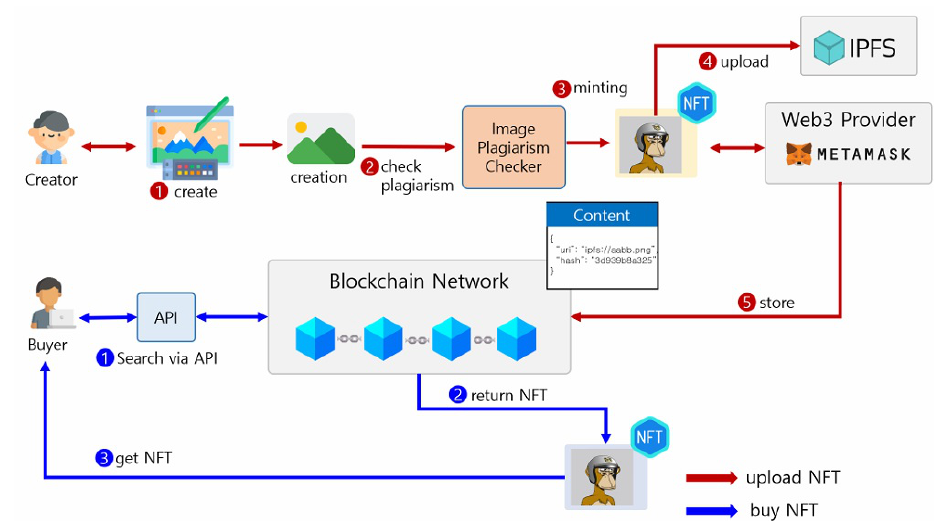
Figure 1. Proposed solution scheme of NFT plagiarism